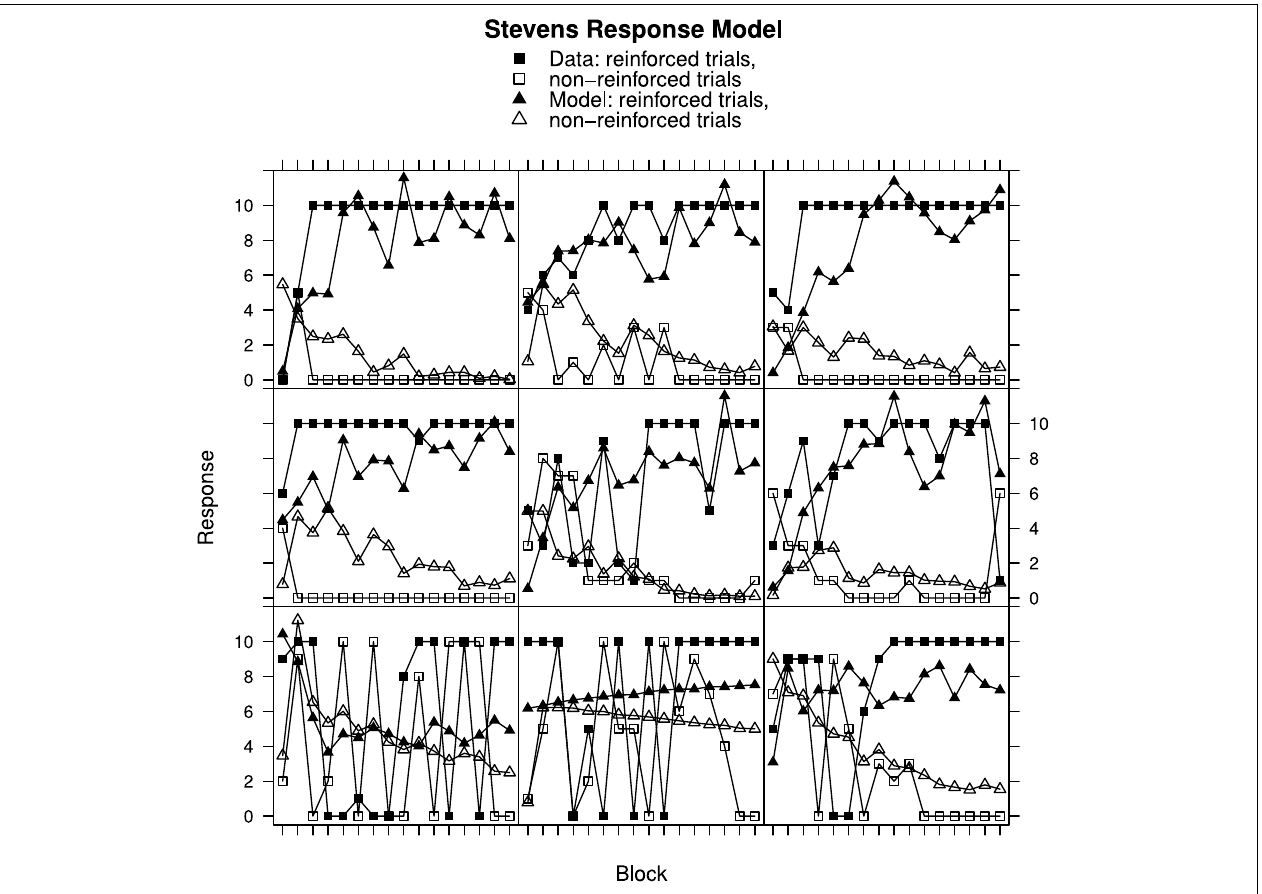
FIGURE 5 | Ratings and MECA Model predictions for reinforced and non-reinforced trials using the Stevens Response Model in Experiment 1. Top row , best fitting model samples. Middle row , intermediate fits. Bottom row , worst fitting model samples. See Results section on page 9 for further details.